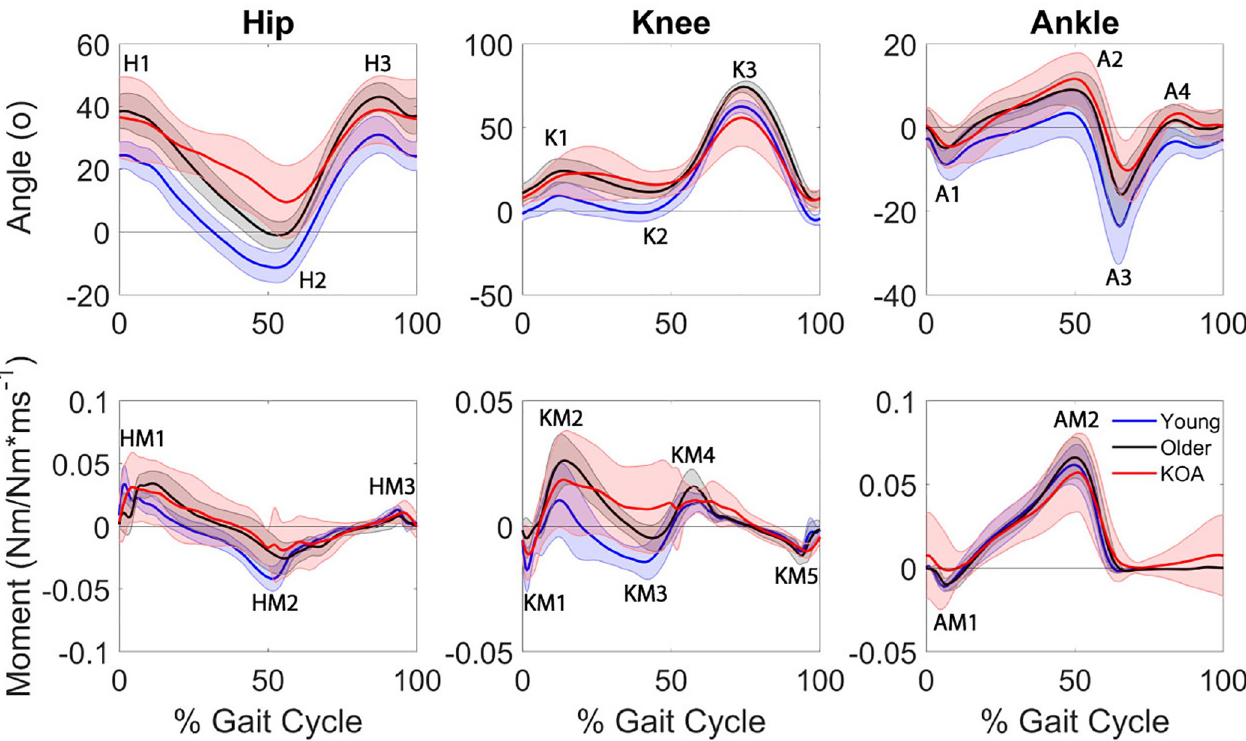
Fig 7. Population sagittal plane joint angles and joint moments (normalized to body weight and height). Solid lines represent population average and shaded error bars represent ± one standard deviation. Positive values represent hip flexion, knee flexion, and ankle dorsiflexion angles and hip extension, knee extension, and ankle plantarflexion